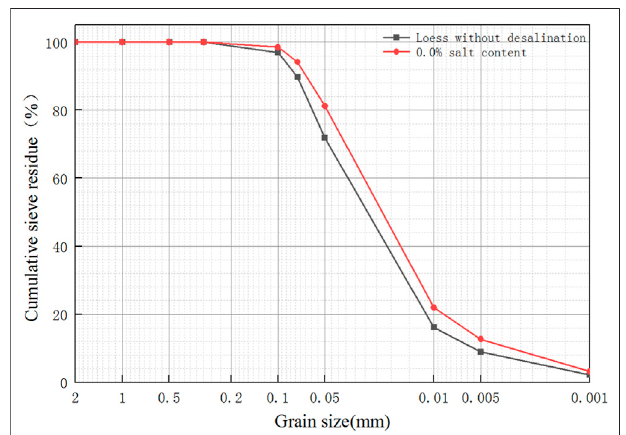
FIGURE 1 | Particle size distribution graph of loess samples before and after salt